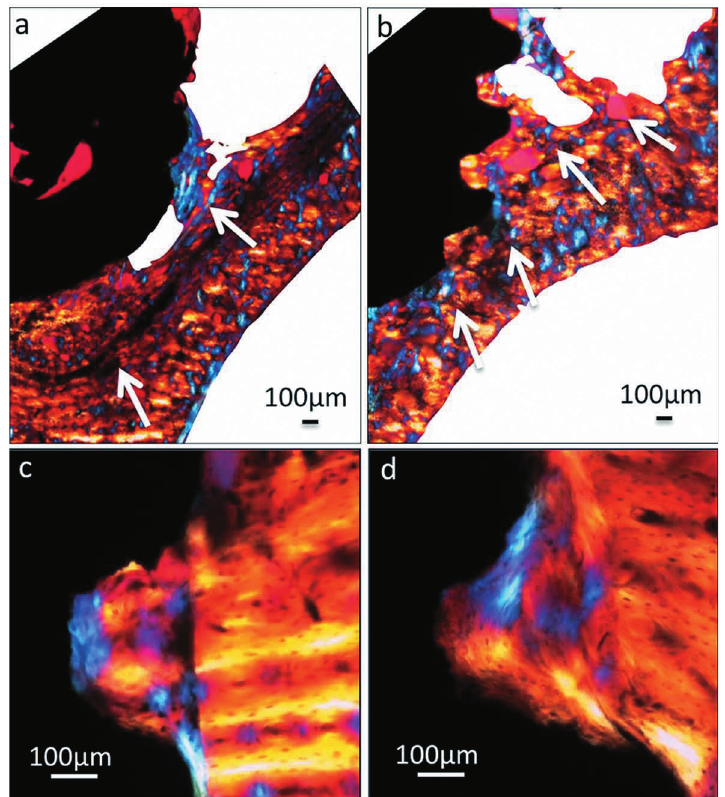
Figure 5- Polarized light micrographs of implant sections at the 28 day period. Apical region in Group 1 (a) and Group 2 (b) (original magnification 4X); cervical region in Group 1 (c) and Group 2 (d) (original magnification 20X). The arrows indicate the direction of osteoconduction from pre-existing bone in direction to the